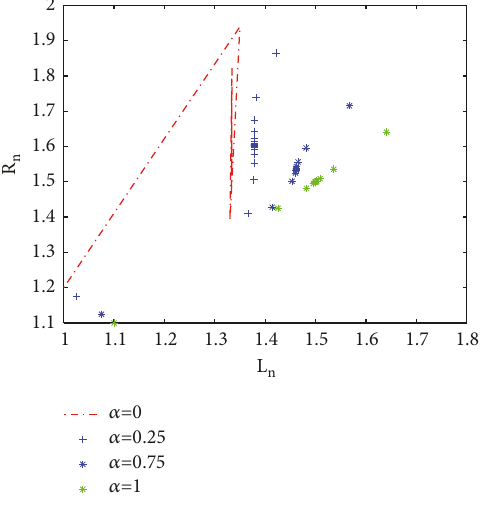
Figure 1: The dynamics of system (64).